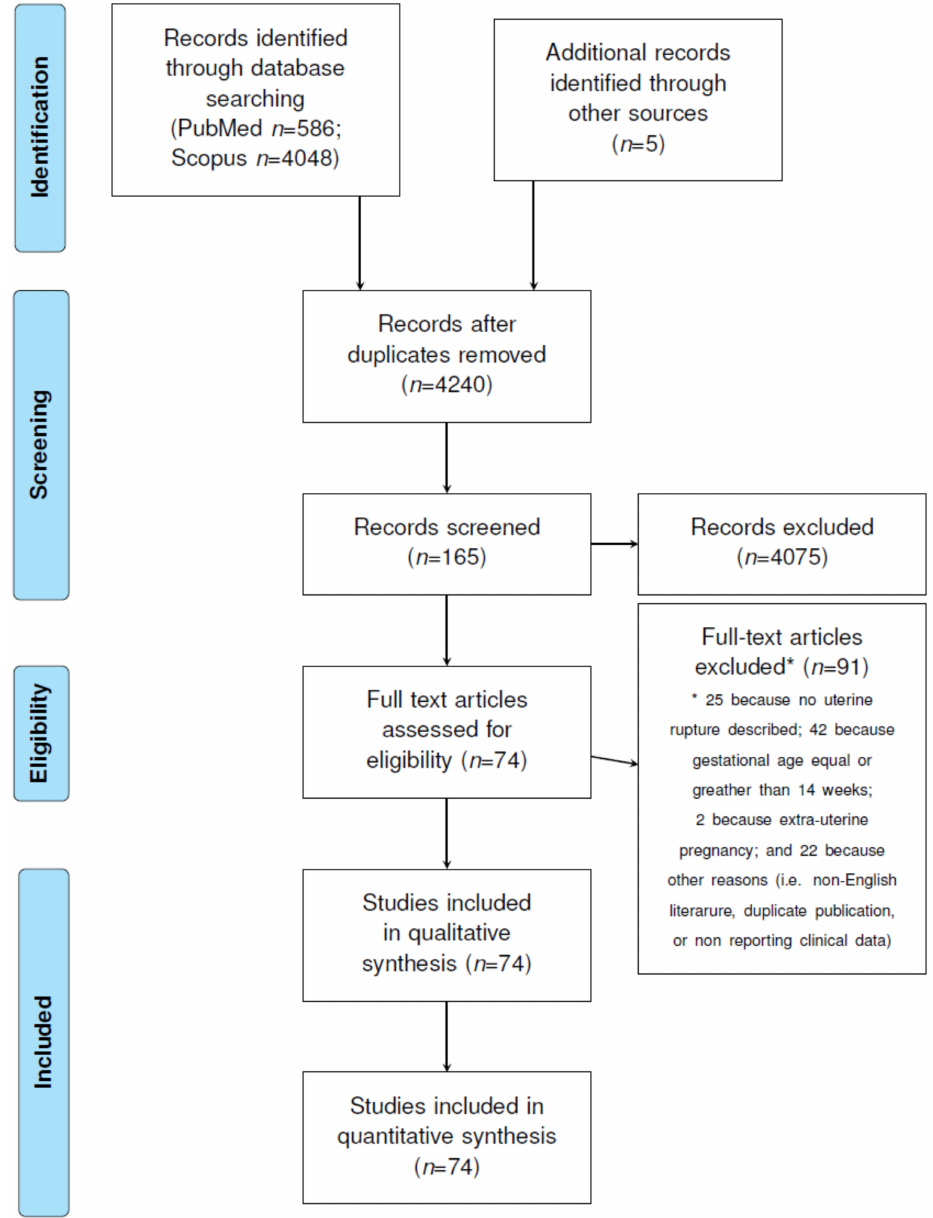
Figure 1. Flow chart of the study based on a Preferred Reporting Items for Systematic Reviews and Meta-Analyses (PRISMA)